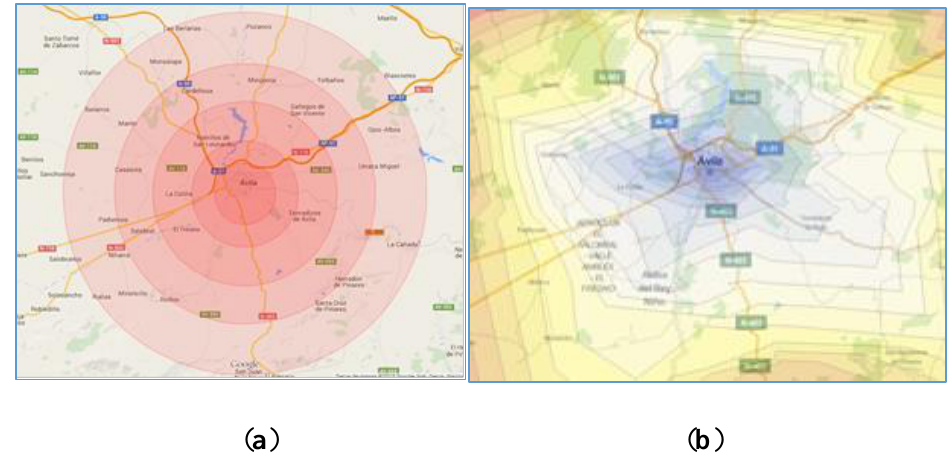
Figure 8. ( a ) Radial isochrones; ( b ) Static isochrones.